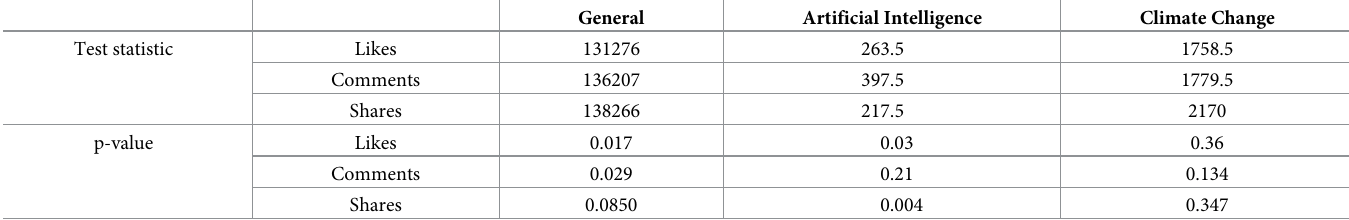
Table 6. (Facebook) test statistics and p-values for the Mann-Whitney U test used for comparing the distributions of posts following and not following the recommendations.